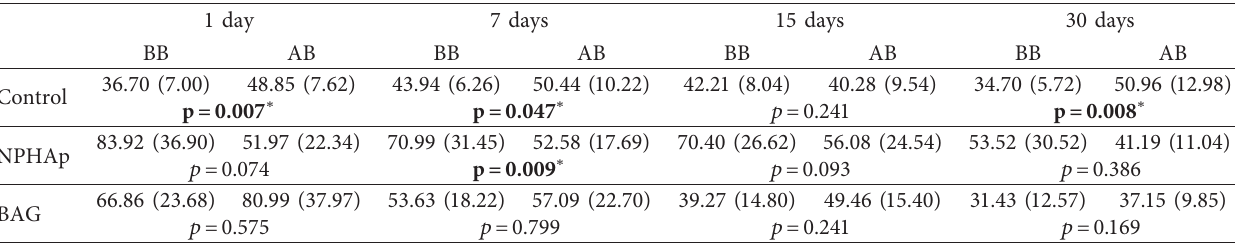
Table 4: Vickers hardness (MPa) before and after brushing for each time interval (days), for each experimental group-mean (standard